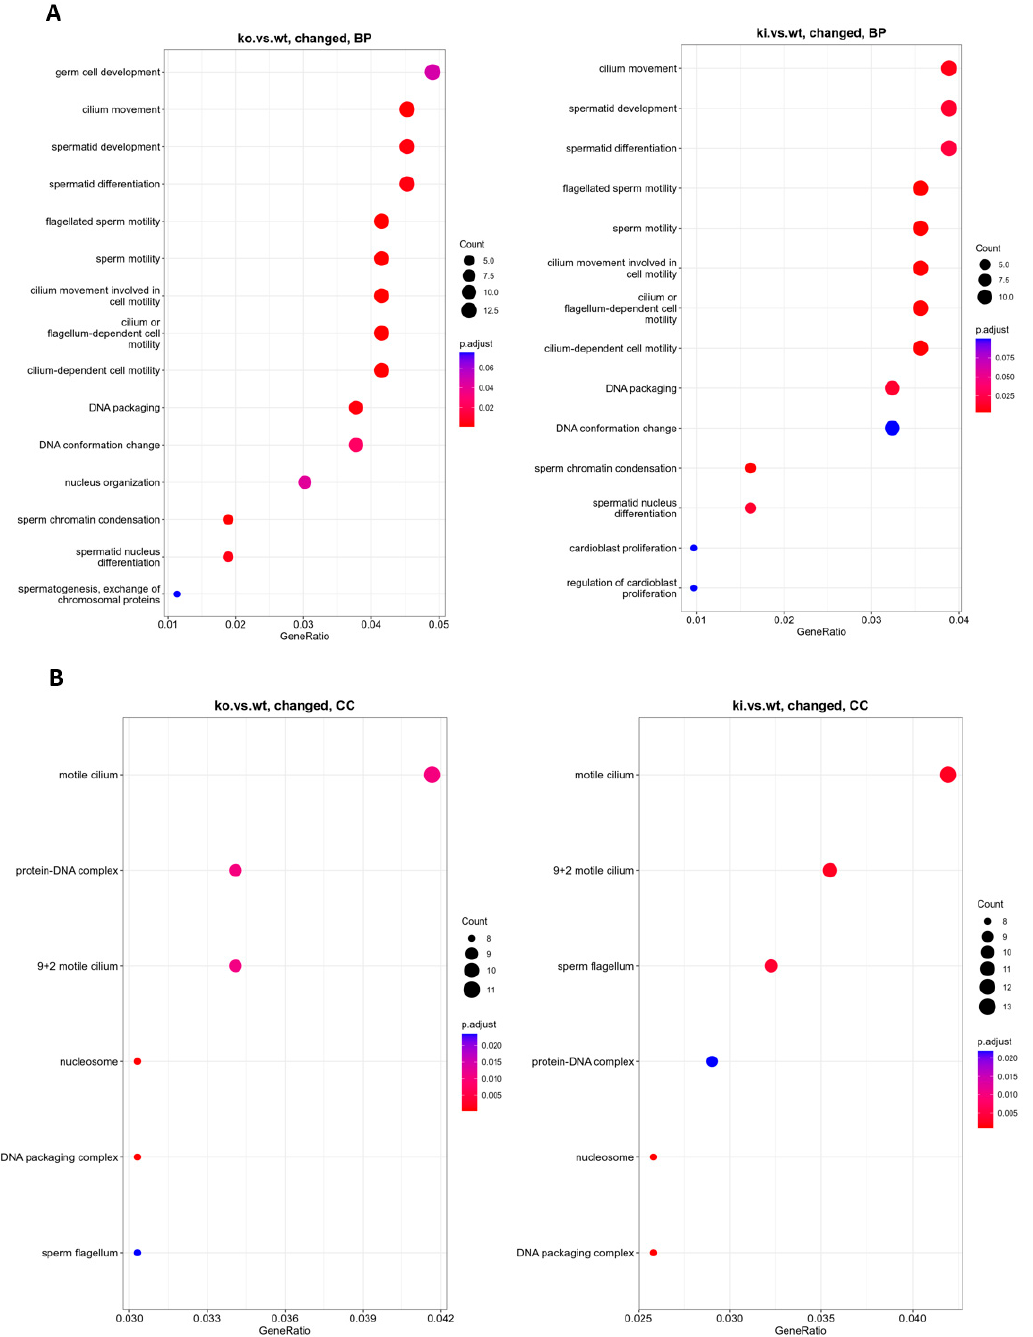
Figure 2. GO functional enrichment analysis on DEGs from RS of KO and KI groups were grouped into different functional categories: biological process (BP), cellular component (CC), and molecular function (MF). ( A ) BP significantly enriched in GO analysis of DEGs ( B ) CC significantly altered in GO analysis of DEGs. The x-axis represents gene ratio = count/set size. The dot size represents the number of genes, and the color of each bar represents the